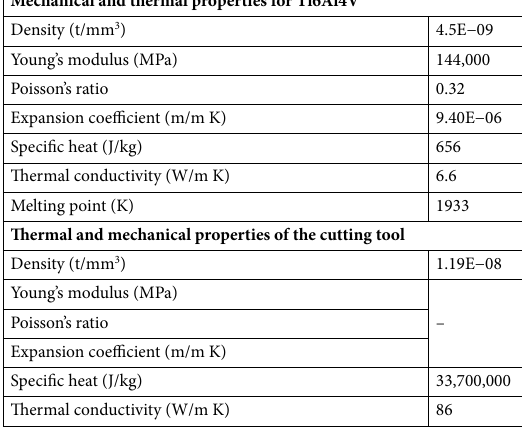
Table 5. Ti6Al4V and tool parameters used in the FEM simulations.